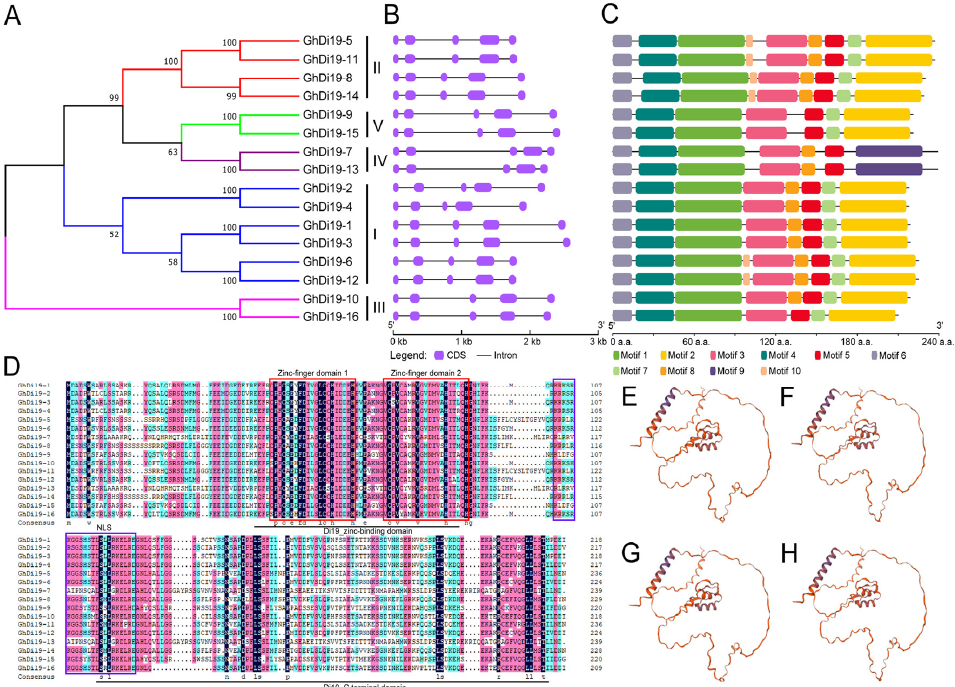
Figure 2. Gene structure, motifs, domains, and protein 3D-structures analysis of 16 GhDi19 genes in G. hirsutum . ( A ) Phylogenetic tree of GhDi19s. A neighbor-joining (NJ) phylogenetic tree was built using MEGA 7.0, and the bootstrap values of 1000 replicates were listed at each branch. ( B ) Structural analysis of 16 GhDi19s . ( C ) Motif of 16 GhDi19 proteins. Ten motifs were investigated using the MEME online tool. ( D ) Multiple sequence alignments of 16 GhDi19 proteins. Two zinc-finger domains and one NLS are marked by red and blue boxes, respectively. Di19_zinc-binding domain and the Di19_C terminal domain of Di19 proteins are underlined in black. ( E – H ) 3D structures of GhDi19-1, GhDi19-2, GhDi19-3, and GhDi19-4 proteins.